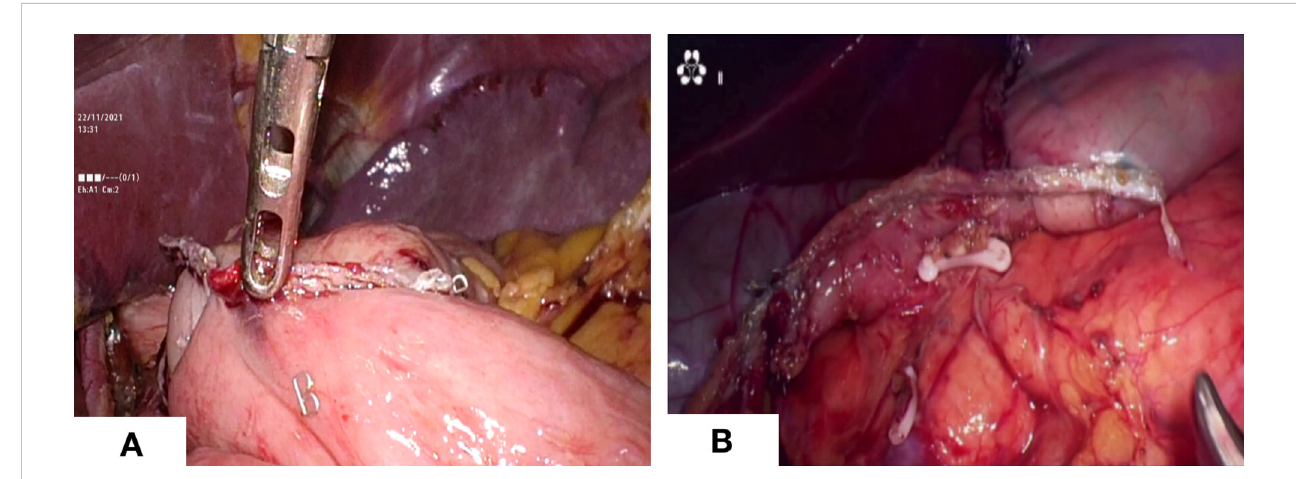
FIGURE 3 Digestive tract reconstruction. (A) Billroth -I anastomosis; (B) Billroth - II